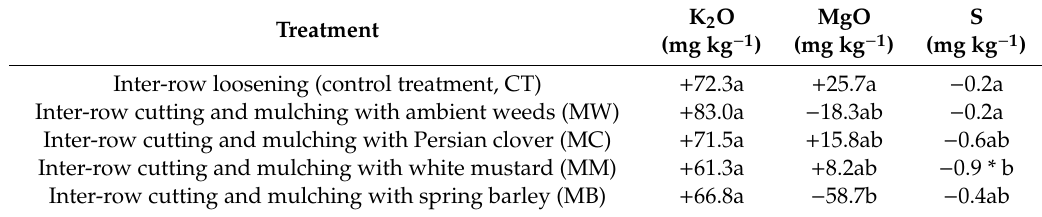
Table 4. The e ff ect of intercropping on the change of soil potassium, magnesium and sulphur, 2015–2017. K 2 O MgO S Treatment (mg kg − 1 ) (mg kg − 1 ) (mg kg − 1 ) Inter-row loosening (control treatment, CT) + 72.3a + 25.7a − 0.2a Inter-row cutting and mulching with ambient weeds (MW) + 83.0a − 18.3ab − 0.2a Inter-row cutting and mulching with Persian clover (MC) + 71.5a + 15.8ab − 0.6ab Inter-row cutting and mulching with white mustard (MM) + 61.3a + 8.2ab − 0.9 * b Inter-row cutting and mulching with spring barley (MB) + 66.8a − 58.7b −